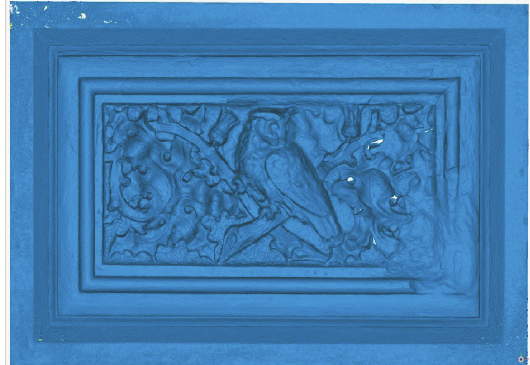
Figure 5. Polygon mesh model created using Agisoft Photoscan